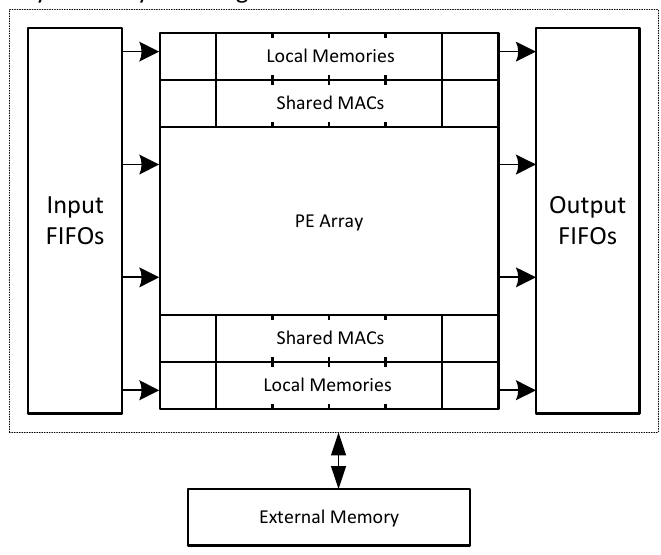
Figure 7. Architecture of